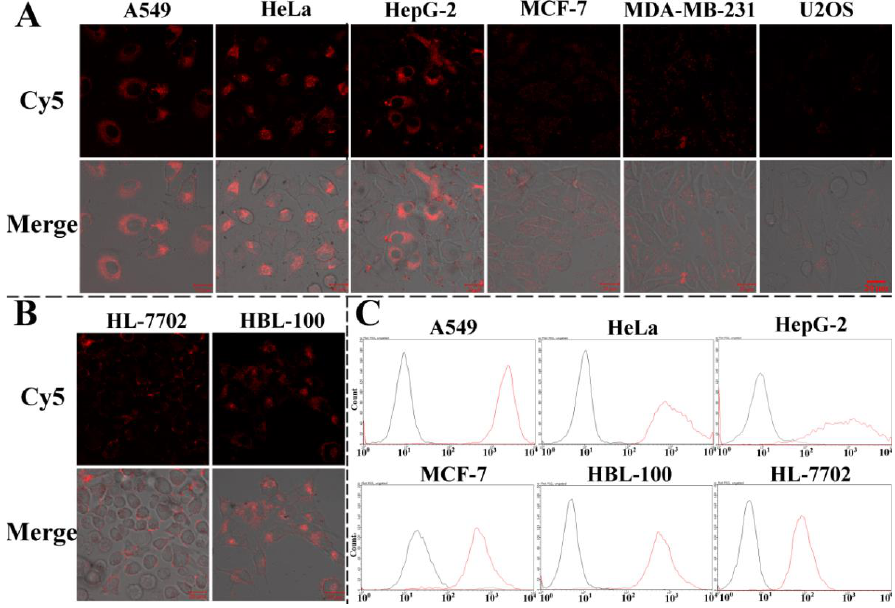
Figure 4. Fluorescence images of different cancer cell lines ( A ) and normal cell lines ( B ) that were treated with AuNF probes (1.5 nM) for 4 h. Flow cytometric analysis of different cell lines ( C ) collected after the CLSM determination.